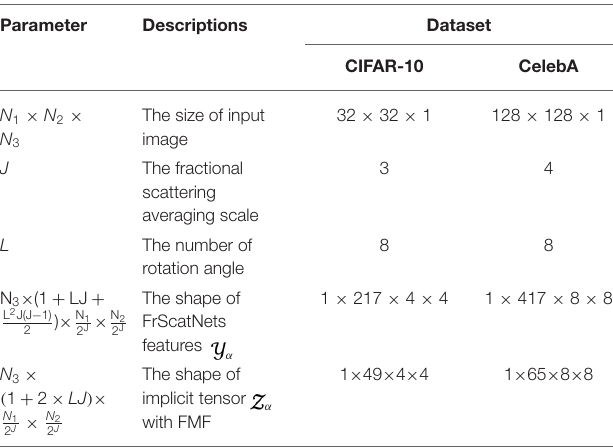
TABLE 2 | Peak signal to noise ratio (PSNR) and structural similarity (SSIM) scores of training and testing images from FrScatNets with fractional orders α 1 = α 2 = 1 on the CIFAR-10 dataset.